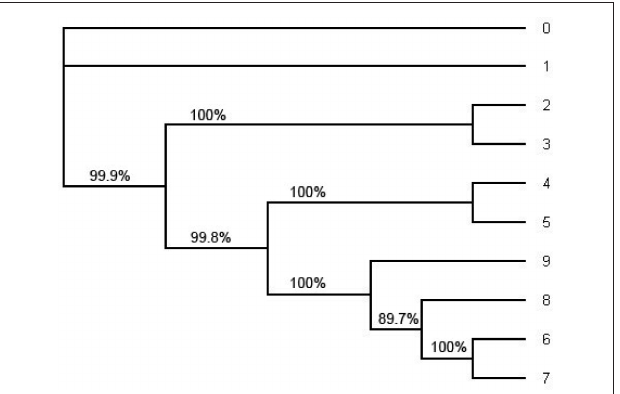
Figure 5 | The ML tree estimated by the software PHYML under HKY model from the whole alignment (including position 1 through position 1505). This is an unrooted tree. The number in each split represents the probability of the split estimated by bootstrapping with the bootstrap sample size 1000. Note that the tree topology of the ML tree is the same as the tree topology of the consensus tree in Figure 4 and the tree topology in Figure 1 .